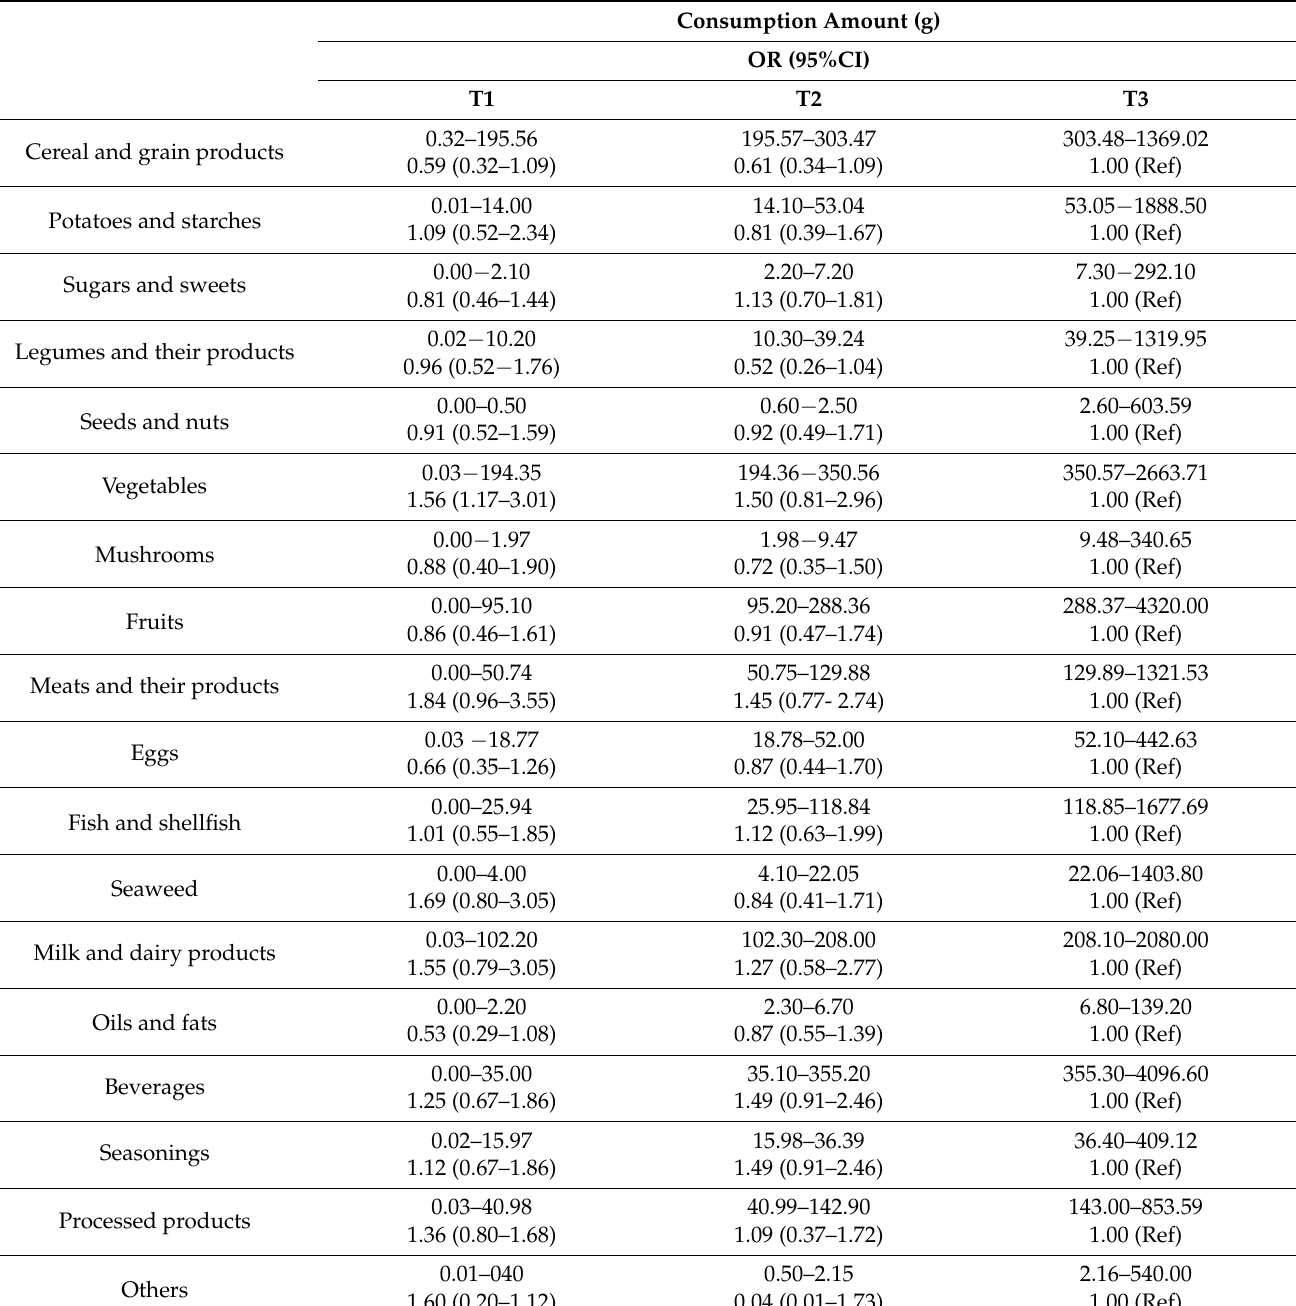
Table 5. Weighted odds ratios of a low HRQoL associated with tertile ranges of food group intake among Korean females ( n =